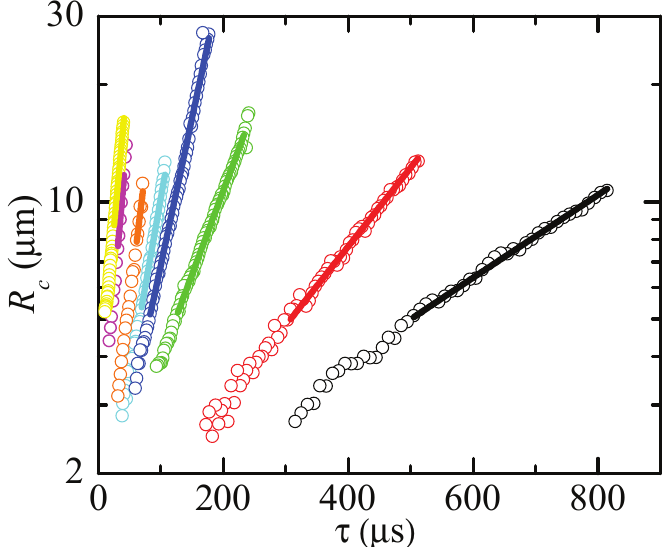
Figure 6. R c as a function of the time to pinching τ for PVP0.07 (yellow), PVP0.1 (magenta), PVP0.2 (orange), PVP0.4 (cyan), PVP0.6 (blue), PVP1 (green), PVP2 (red) and PVP3 (black). The solid lines are the fits of the function (8) to the experimental data.